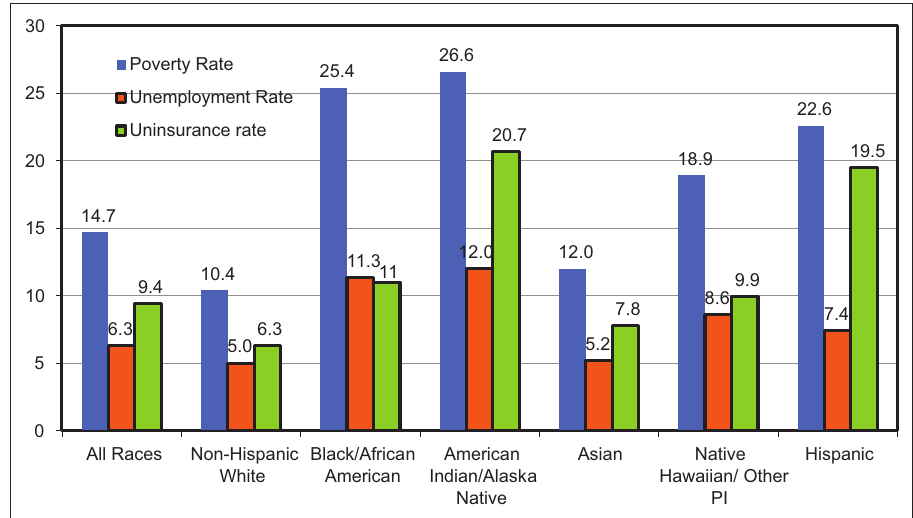
Figure 1. Poverty, Unemployment, and Health Uninsurance Rates (%) by Race/Ethnicity, United States, 2015 Source: US Census Bureau. 2015 American Community Survey.